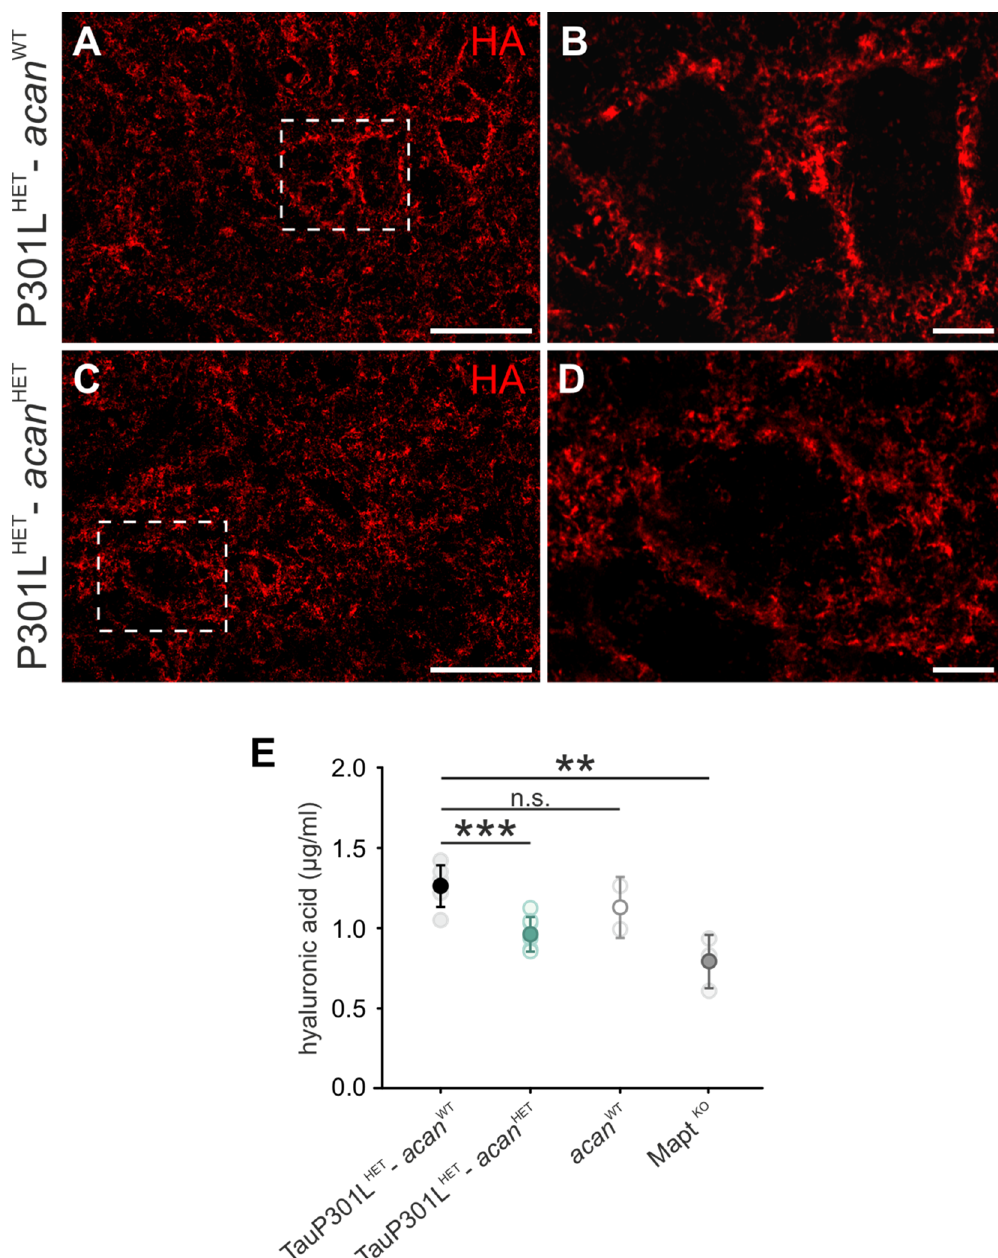
Figure 4. Characterization of hyaluronic acid in the Mo5 of TauP301- acan mice. ( A – D ) Immunohistochemical analysis of hyaluronic acid (HA) (bHABP (Merck Millipore)) in the motor trigeminal nucleus (Mo5) of 3 TauP301L HET - acan WT (A, B) and 3 TauP301L HET - acan HET mice ( C , D ). High magnification confocal images ( B , D ) of HA immunoreaction visualize location and structure of the immunoreaction. Comparison of the structure and location of HA immunoreaction did not reveal any genotype-specific differences between TauP301L HET - acan WT ( B ) and TauP301L HET - acan HET mice ( D ). Location of HA immunoreaction was limited to the extracellular area in both genotypes ( A , C ). ( E ) The amount of HA in TauP301L HET - acan WT and TauP301L HET - acan HET mice was determined by direct ELISA technique. The level of HA was significantly reduced in TauP301L HET - acan HET mice compared to TauP301L HET - acan WT mice ( p < 0.001, TauP301L HET - acan WT n = 6, TauP301L HET - acan HET n = 7, t -test). Comparison of TauP301L HET - acan WT and acan WT mice did not yield any genotype-specific difference. HA level was significantly decreased in in Mapt KO mice compared to TauP301L HET - acan WT mice ( p = 0.002, TauP301L HET - acan WT n = 3, Mapt KO n = 6, t -test). Data are given as mean ± SD, ** p < 0.01, *** p < 0.001, n.s. not significant. Scale bar in ( A , C ) 50 µ m, in ( B , D ) 10 µ